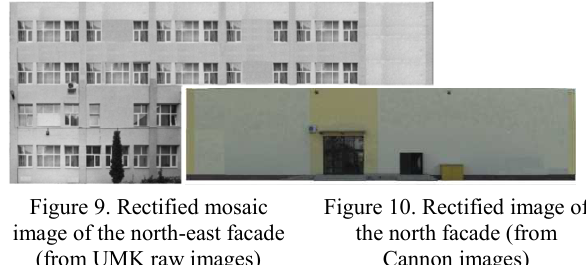
Figure 9. Rectified mosaic image of the north-east facade (from UMK raw images)